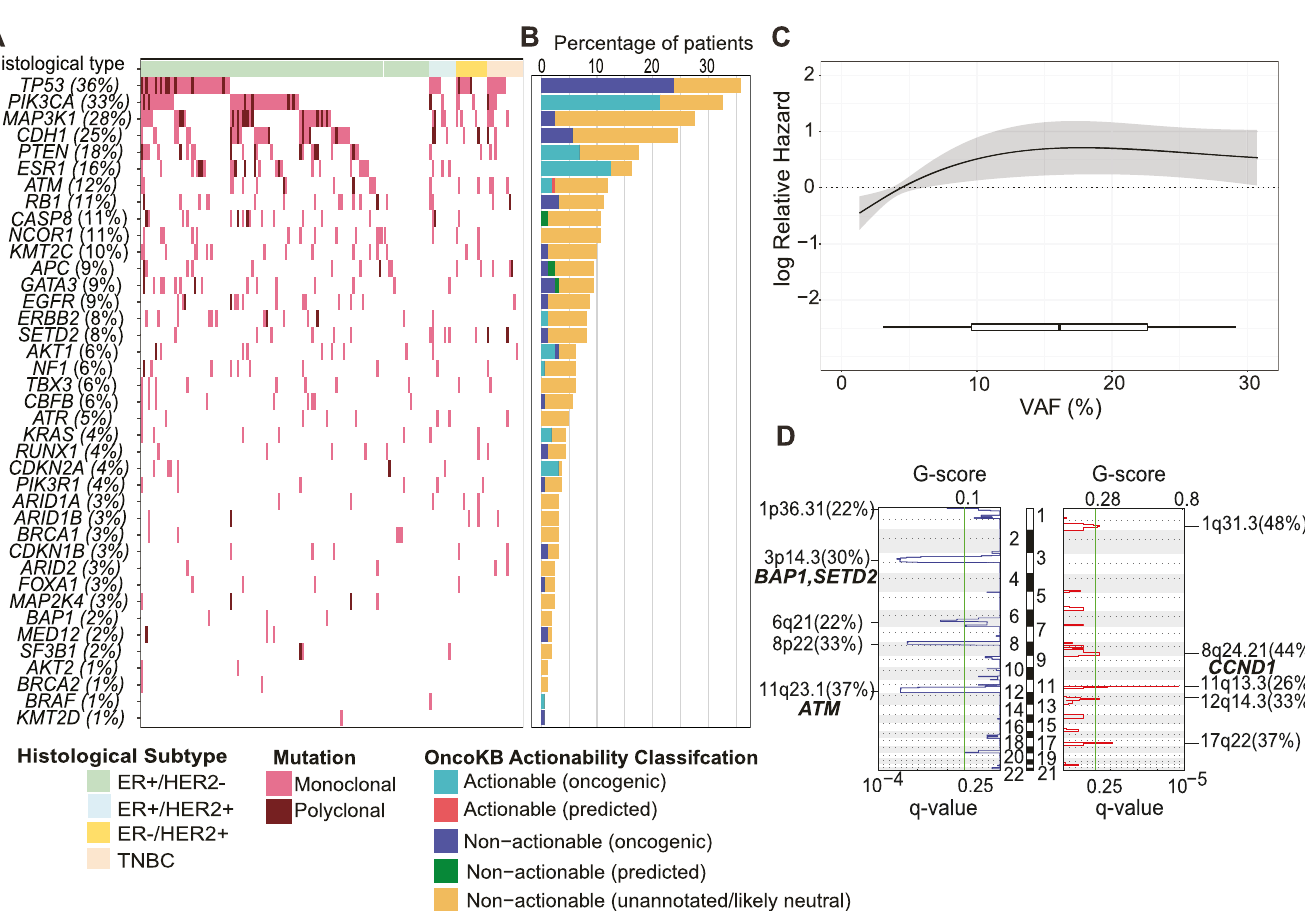
Fig 3. Next-generation sequencing of plasma samples at baseline. (A) Heatmap of mutations detected across all samples tested with the 39-gene targeted sequencing panel. Patients are ranked based on their histological subtype and the frequency of observed mutations. (B) Percentage of patients with actionable mutations detected from targeted sequencing based on the OncoKB classification database. (C) Cubic spline regression model showing the association between ctDNA VAF (as assessed by targeted sequencing) and overall survival (95% CI represented by shading). (D) GISTIC analysis showing copy number alterations from LC-WGS analysis ( n = 27) with deleted (left) and amplified (right) chromosomal regions and genes indicated. Green line indicates the significance threshold for copy number alterations (q-value 0.25). ctDNA, circulating tumour DNA; ER, estrogen receptor; HER2, human epidermal growth factor receptor 2; LC-WGS, low-coverage whole-genome sequencing; TNBC, triple negative breast cancer; VAF, variant allele